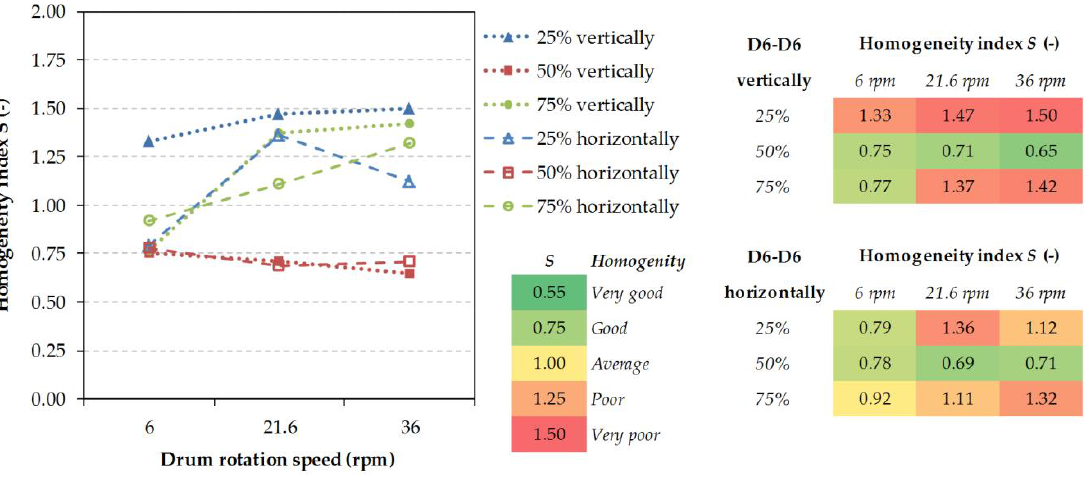
Figure 8. Resulting homogeneity indices for different operating conditions (D6-D6 particles).